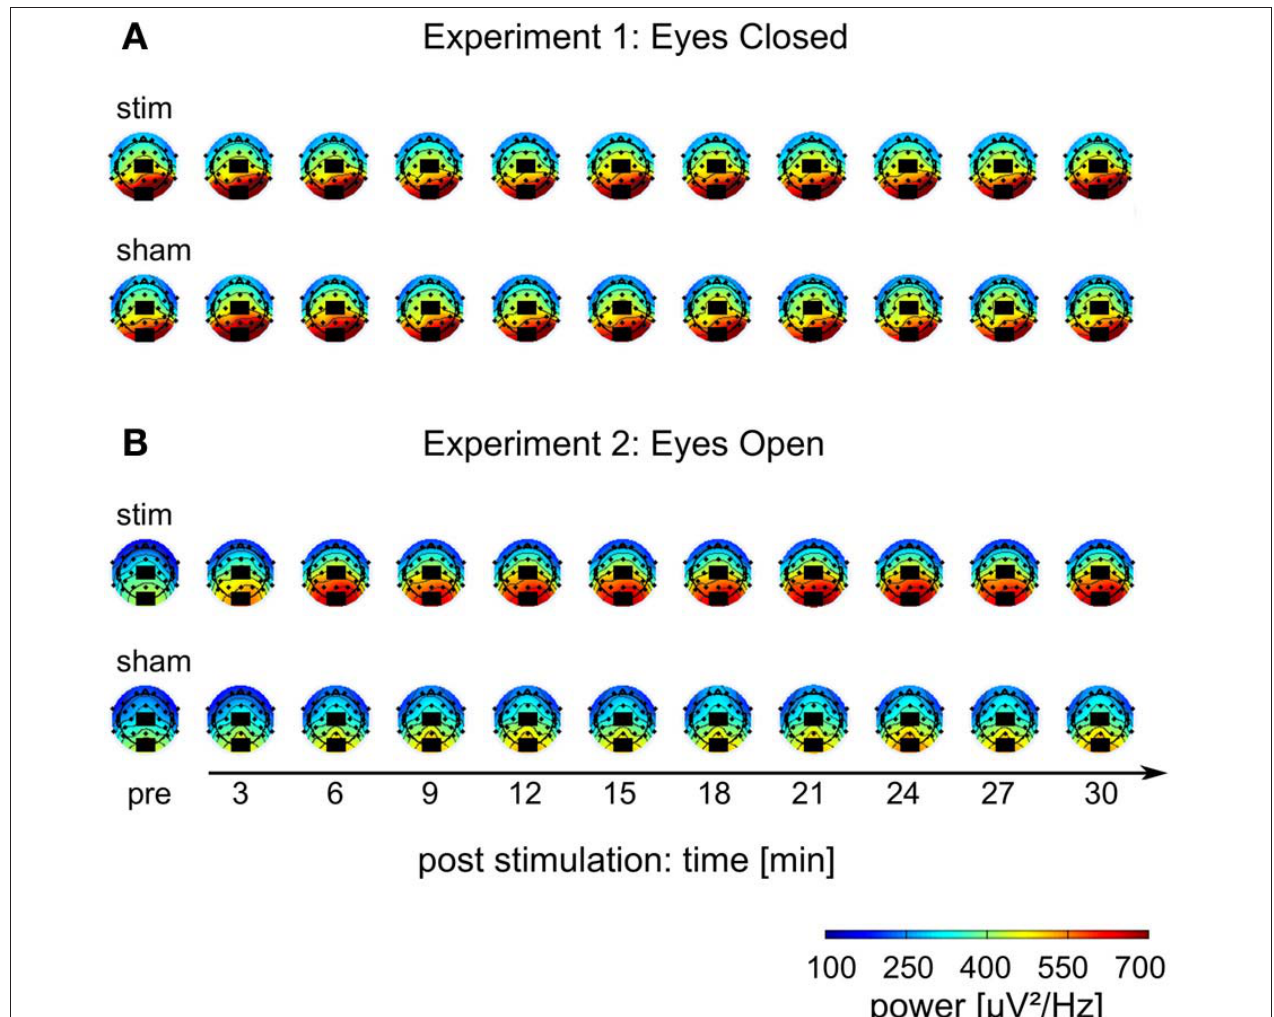
FIGURE 5 | Topographies of IAF power. (A) Experiment 1, (B) Experiment 2; colors depict power. Black rectangles illustrate the placement of the stimulation